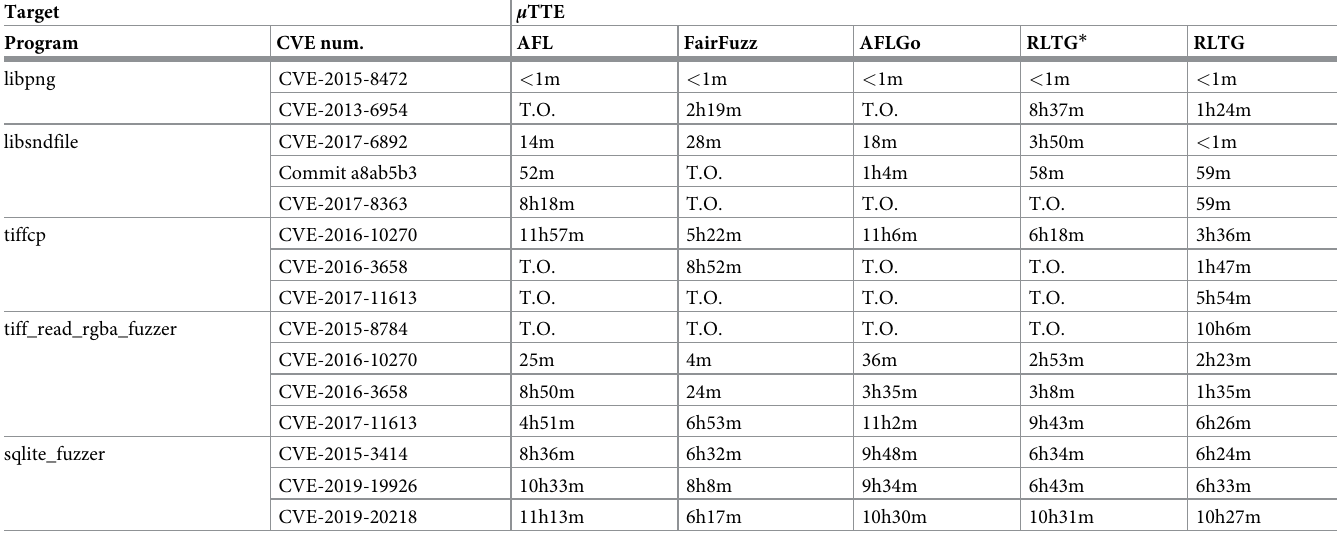
T.O. means that within 12 hours, the fuzzer could not reproduce the